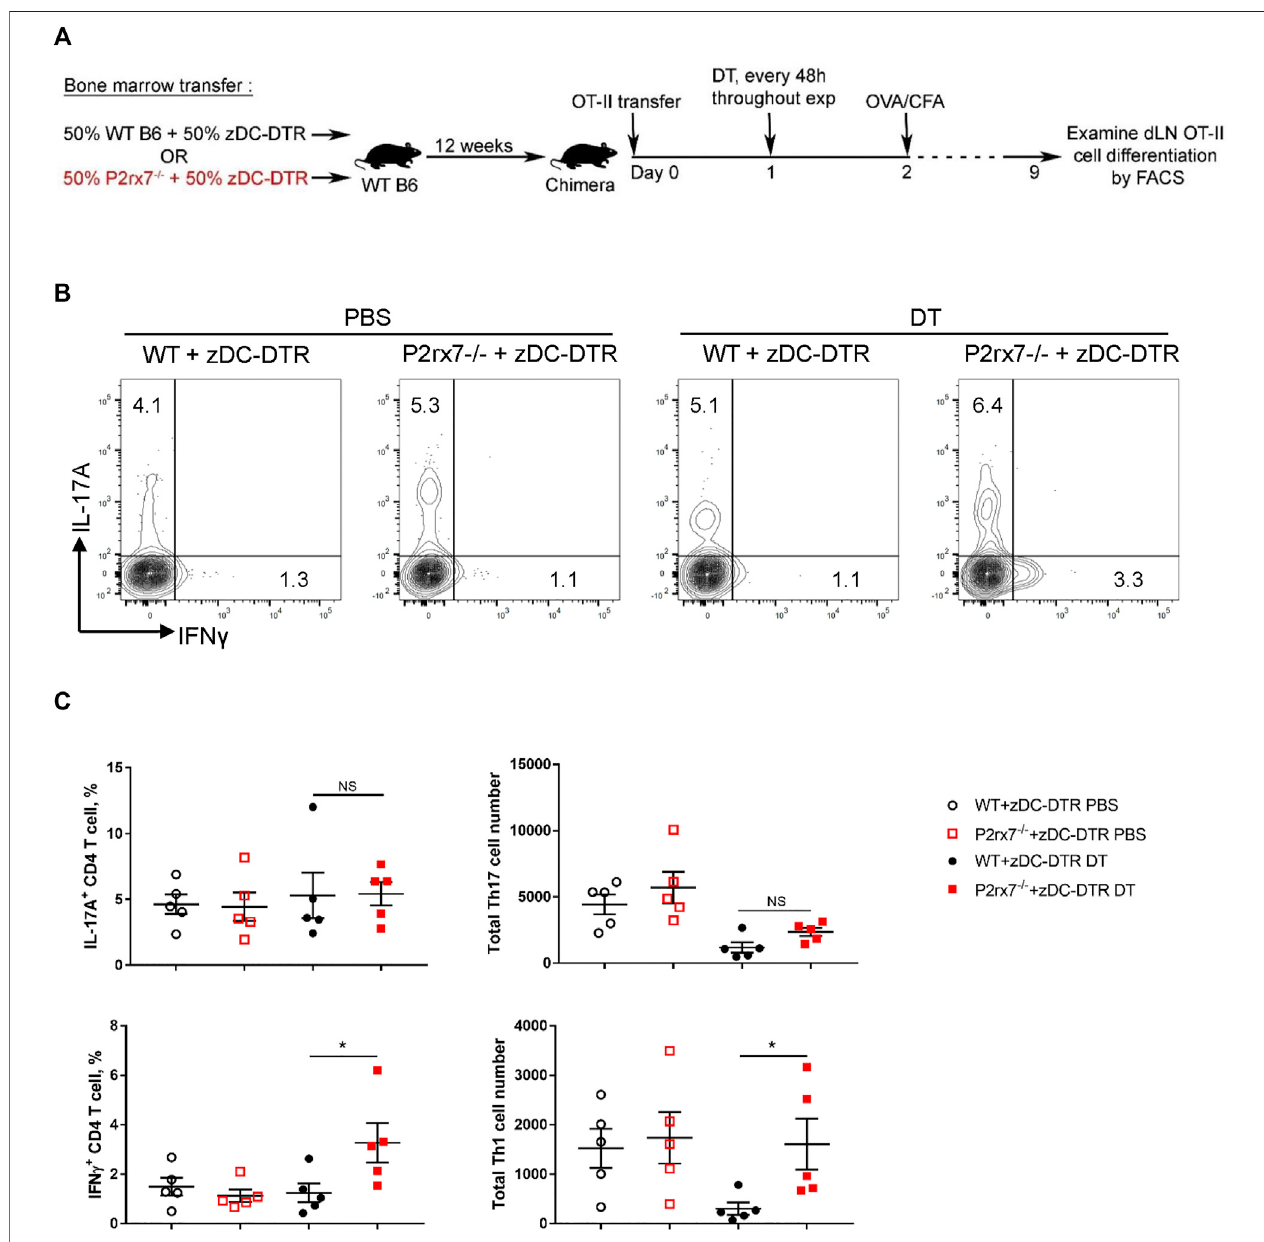
FIGURE 3 | P2X7R on cDCs is not required in vivo for Th17 differentiation. (A – C) Mixed bone marrow chimeras were established by reconstituting irradiated WT micewithbone marrow from eitherWTor P2rx7 − / − mice and zDC-DTR mice mixedat 1:1ratio(WT+zDC-DTR andP2rx7 − / − +zDC-DTR, respectively).After10 weeks, chimeras were intravenously transferred with 1 × 10 5 naive OT-II CD4 + T cells 1 day prior to injection with diphtheria toxin (DT) or vehicle. DT was injected every 48 h throughout the course ofthe experiment. 24 h following initial DT treatment, chimeras were immunized withOVA 323-339 /CFA, according toschematic (A) On day 9 inguinal LNs were collected, restimulated, and analyzed by fl ow cytometry. (B) Representative fl ow contour plots. Cells were gated on CD3 + CD4 + CD45.2 + CD45.1 + OT-II cells. (C) The percentage of IL-17A + and IFN γ + OT-II T cells and cell number were quantitated. Results shown are mean ± SEM, each dot represents an individual mouse. One representative of two independent experiments. * p < 0.05, ** p < 0.01; NS, not signi fi cant.